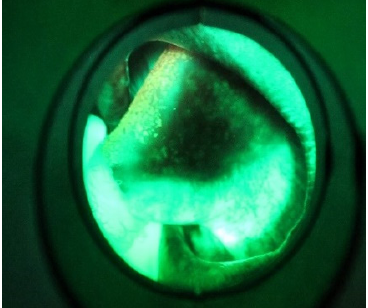
Figure 9. VELscope image of oral cavity.